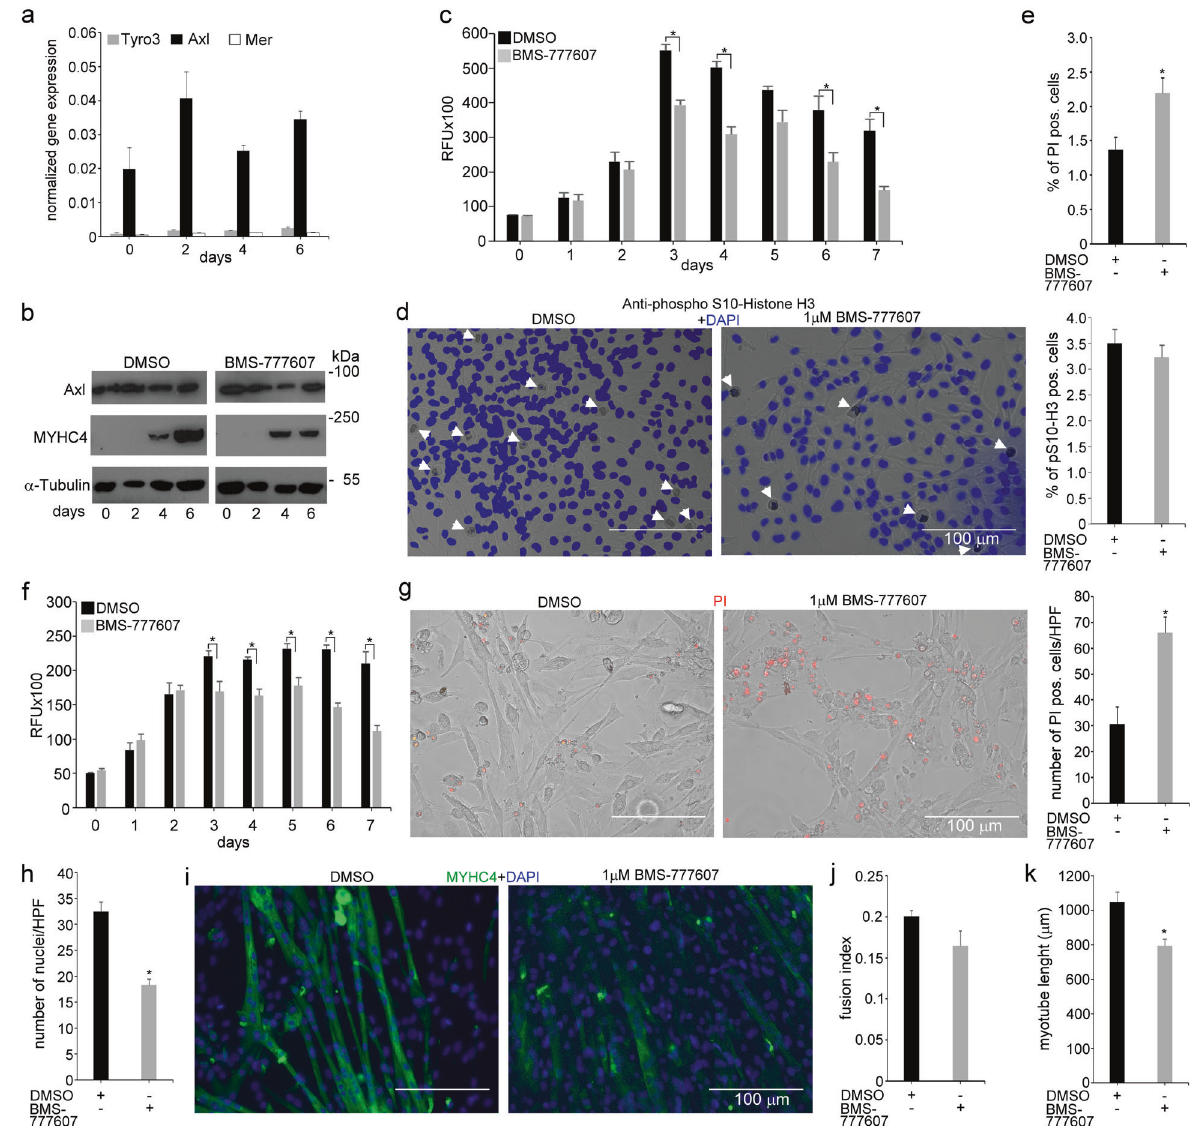
Fig. 6 In vitro administration of the pan-TAM tyrosine kinase inhibitor BMS-777607 impairs myogenesis of C2C12 myoblast cells. a mRNA expression levels of Tyro3, Axl, and Mer during the differentiation of C2C12 myoblast cells determined by qRT-PCR. b Protein expression levels of Axl and myosin heavy chain 4 (MYHC4) in differentiating C2C12 myoblasts in the presence or absence of 1 μ M BMS- 777607 determined by Western blot analysis. α -Tubulin was used as a loading control. One representative blot of three is shown. c Alterations in the number of viable C2C12 cells grown in growth medium in the presence or absence of 1 μ M BMS-777607 determined by PrestoBlue staining. d Percent of cells in G2/M phase grown in growth medium in the presence or absence of 1 μ M BMS-777607 as indicated by anti- phospho-histone H3 (Ser10) and DAPI co-staining (at least 20 HPF were analyzed). Arrows point to the anti-phospho-histone H3 positive nuclei. e Percent of PI-positive cells grown in growth medium in the presence or absence of 1 μ M BMS-777607. f Alterations in the number of viable C2C12 cells grown in differentiation medium in the presence or absence of 1 μ M BMS-777607 determined by PrestoBlue staining. BMS- 777607 was added when the medium was changed to differentiation medium. g Representative light microscopic images of C2C12 myoblasts differentiated for 6 days in the absence or presence of 1 μ M BMS-777607 after staining dead cells with propidium iodide and quanti fi cation of propidium iodide-positive nuclei per high-power fi eld (at least 20 HPF were analyzed). h Number of nuclei per high-power fi eld of C2C12 cells differentiated for 6 days in the absence or presence of 1 μ M BMS-777607. i Representative fl uorescent microscopic images of C2C12 myoblasts differentiated for 6 days in the absence or presence of 1 μ M BMS-777607. MYHC4 was visualized by using anti-MYHC4 antibody (green) and nuclei by DAPI (blue). j Fusion index of C2C12 cells differentiated for 6 days in the absence or presence of 1 μ M BMS-777607. k The length of myotubes generated from C2C12 myoblasts differentiated for 6 days in the absence or presence of 1 μ M BMS-777607. All the data are expressed as mean ± SEM of three independent experiments. Asterisks indicate statistical signi fi cance (* P < 0.05, Student ’ s t -test). Scale bars, 100 µm. efferocytosis receptor to be also required for proper myogenesis, receptors (brain-speci fi c angiogenesis inhibitor 1 (BAI1) and but acting as a myotube growth and survival receptor. The stabilin-2) on the surface of myoblasts has already been reported potential involvement of GAS6 and Axl in the muscle develop- to be a prerequisite for cell fusion during muscle fi ber formation ment process is also supported by a recent observation that the [38, 47]. Our data identify Axl, as a third PS-dependent Cell Death and Disease (2021)